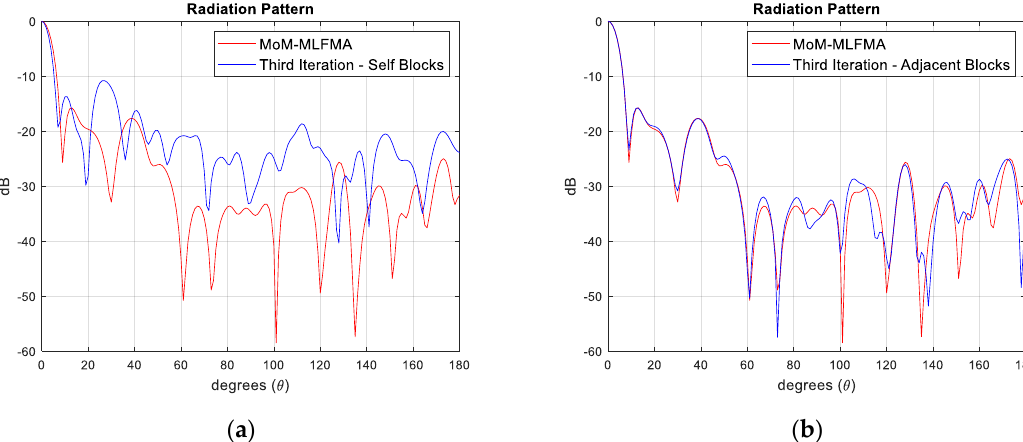
Figure 7. Radiation pattern results for the φ = 0 ° angular cut: ( a ) considering the proposed approach with only self-block coupling and three iterations; ( b ) considering the proposed approach with self and neighboring block coupling and three iterations.